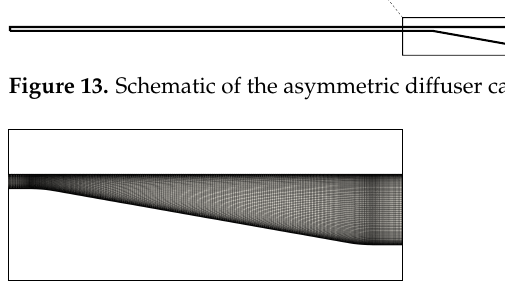
Figure 13. Schematic of the asymmetric diffuser case